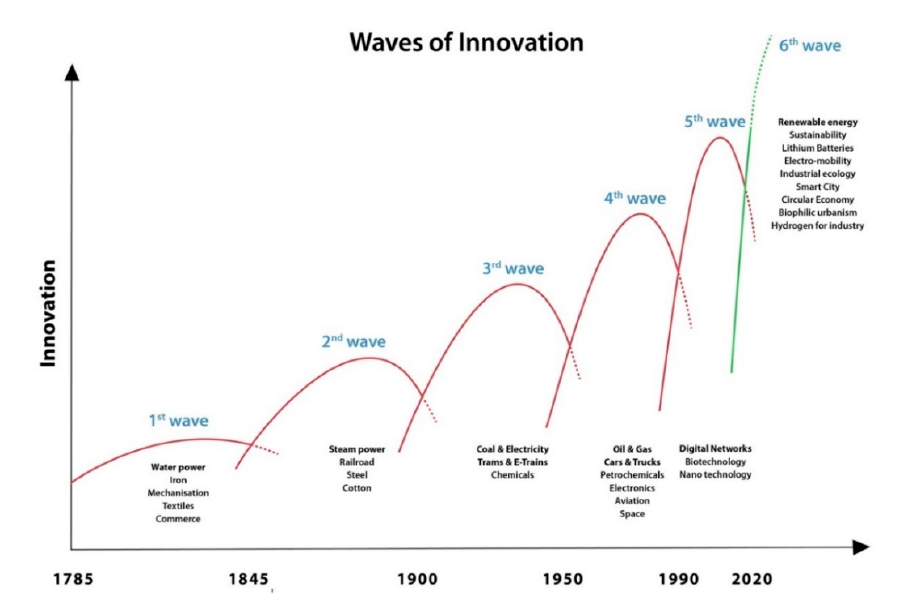
Figure 1. Waves of innovation through industrial history and into the future. Source: Adapted from Hargroves and Smith [10].